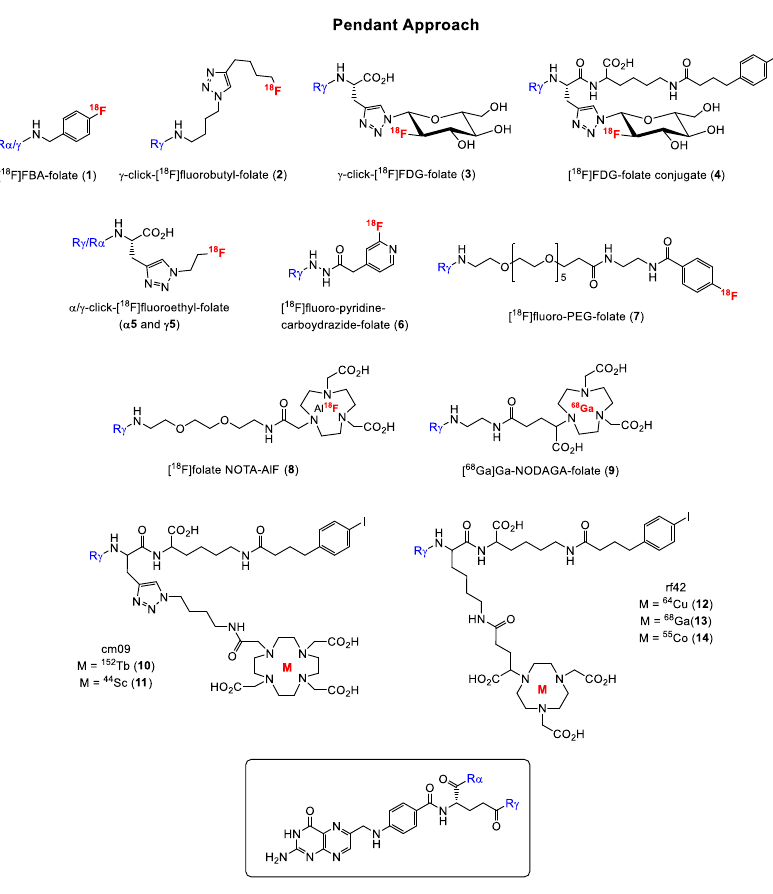
Figure 4. Structures of some notable and promising FA radiotracers prepared using pendant approach. For simplicity, radiometal coordination by chelators not shown.